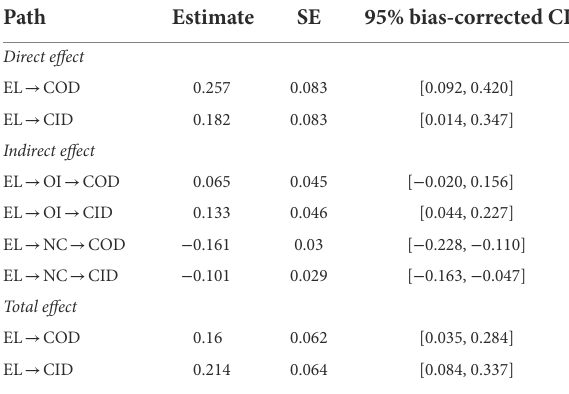
TABLE 6 Standardized direct, indirect, total effects and 95% bias- corrected